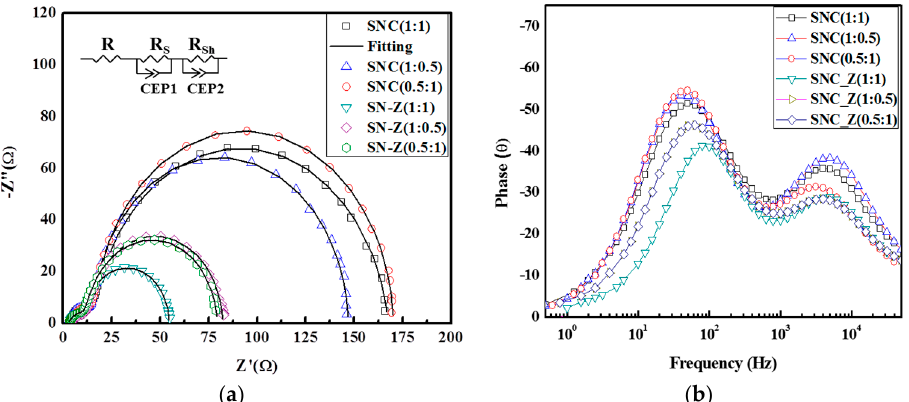
Figure 8. ( a ) Impedance spectra; and ( b ) bode phase plots of the DSSCs based on different photoanodes. Table 2. Equivalent circuit parameters, electron lifetime ( τ e ), effective diffusion coefficient ( D eff ), and effective diffusion length ( L e ) of the DSSCs based on different photoanodes.